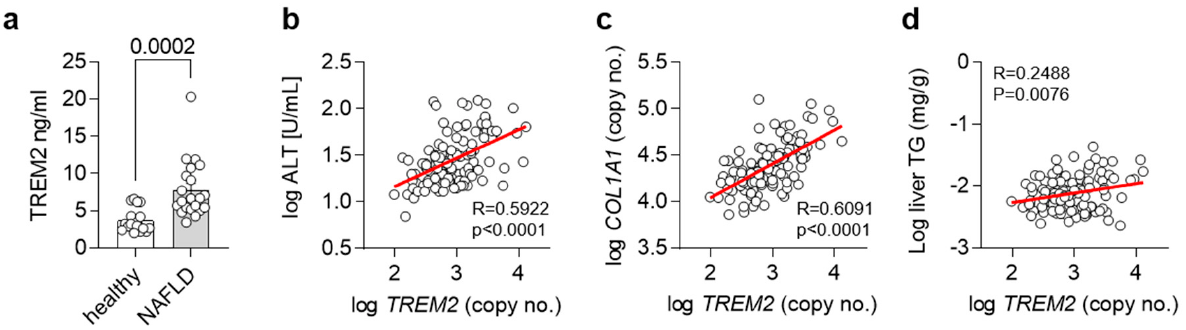
Figure 5. TREM2 in human NAFLD. ( a ) Levels of soluble TREM2 in human healthy controls or NASH patients ( n = 19–21). ( b – d ) Correlation of hepatic TREM2 expression with ( b ) plasma ALT levels, ( c ) hepatic COL1A1 and ( d ) liver triglyceride (TG) levels in a human cohort ( n = 120). ( a ) Data are shown as mean + SEM. Statistically significant differences between groups ( p < 0.05) were determined by Student’s t -test and are indicated as p -value. ( b – d ) Correlation is given as Pearson R.